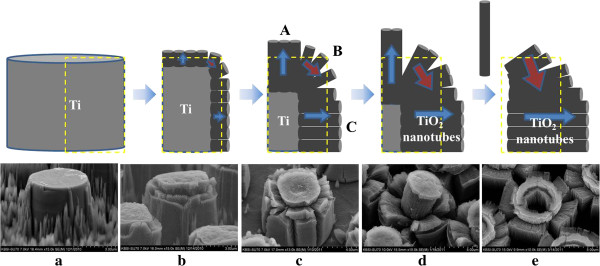
Schematic mechanism for blooming of TiO2 micro-flowers with anodizing time. (a) 0 min, (b) 1 min, (c) 3 min, (d) 5 min, and (e) 7 min.